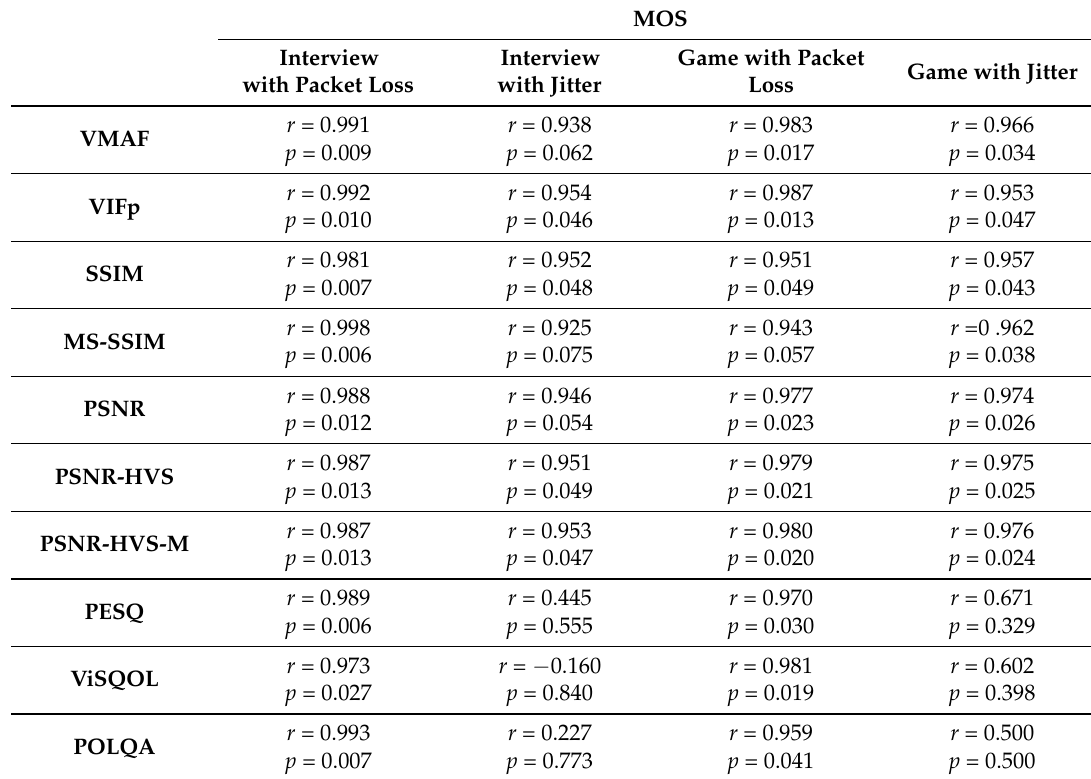
Table 3. Pearson correlation ( r ) and statistical significance ( p ) of the subjective (MOS) for video and audio compared to the objective results (VMAF, VIFp, SSIM, MS-SSIM, PSNR, PSNR-HVS, and PSNR-HVS-M; PESQ, ViSQOL, and POLQA) for the two types of sequences (interview and game) in the different network scenarios (packet loss and